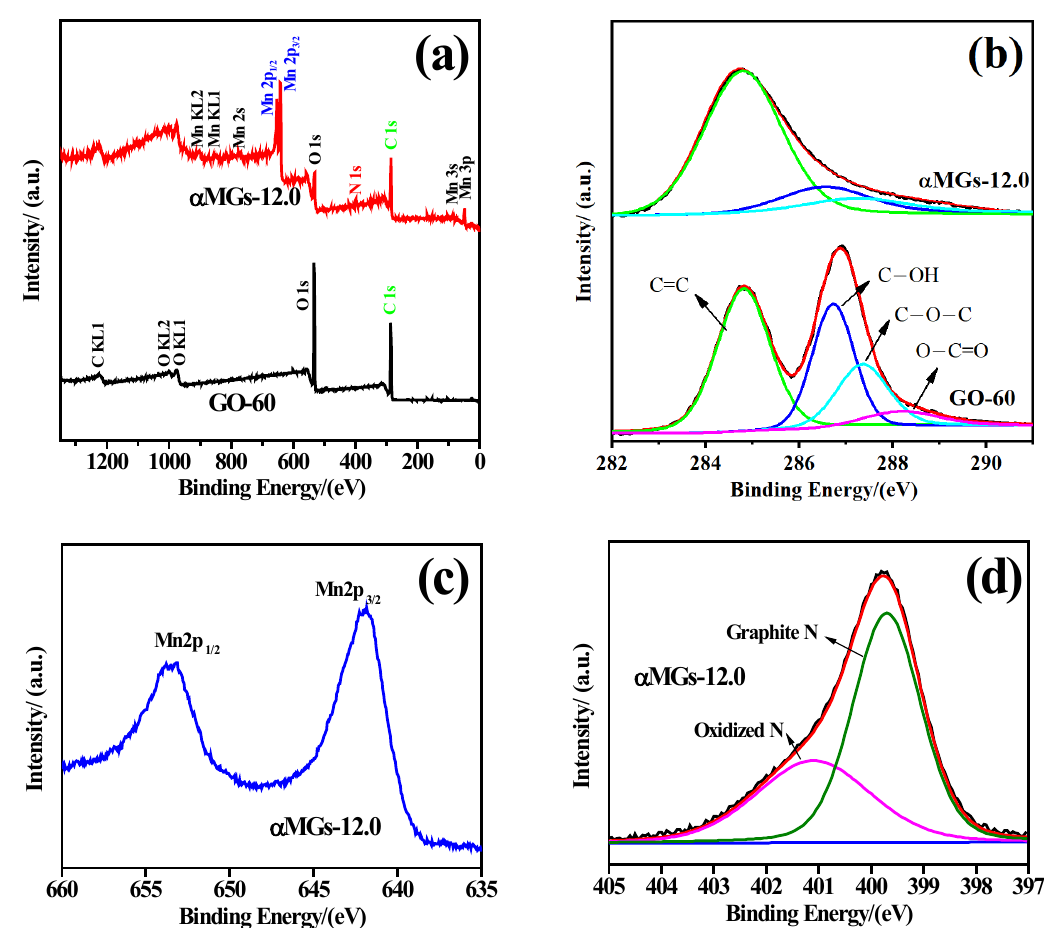
Figure 7. XPS spectra of GO-60 and α MGs-12.0 sample. ( a ) Full XPS spectrum; ( b ) C1s spectrum; ( c ) Binding energy of manganese; ( d ) XPS spectrum of N1s.